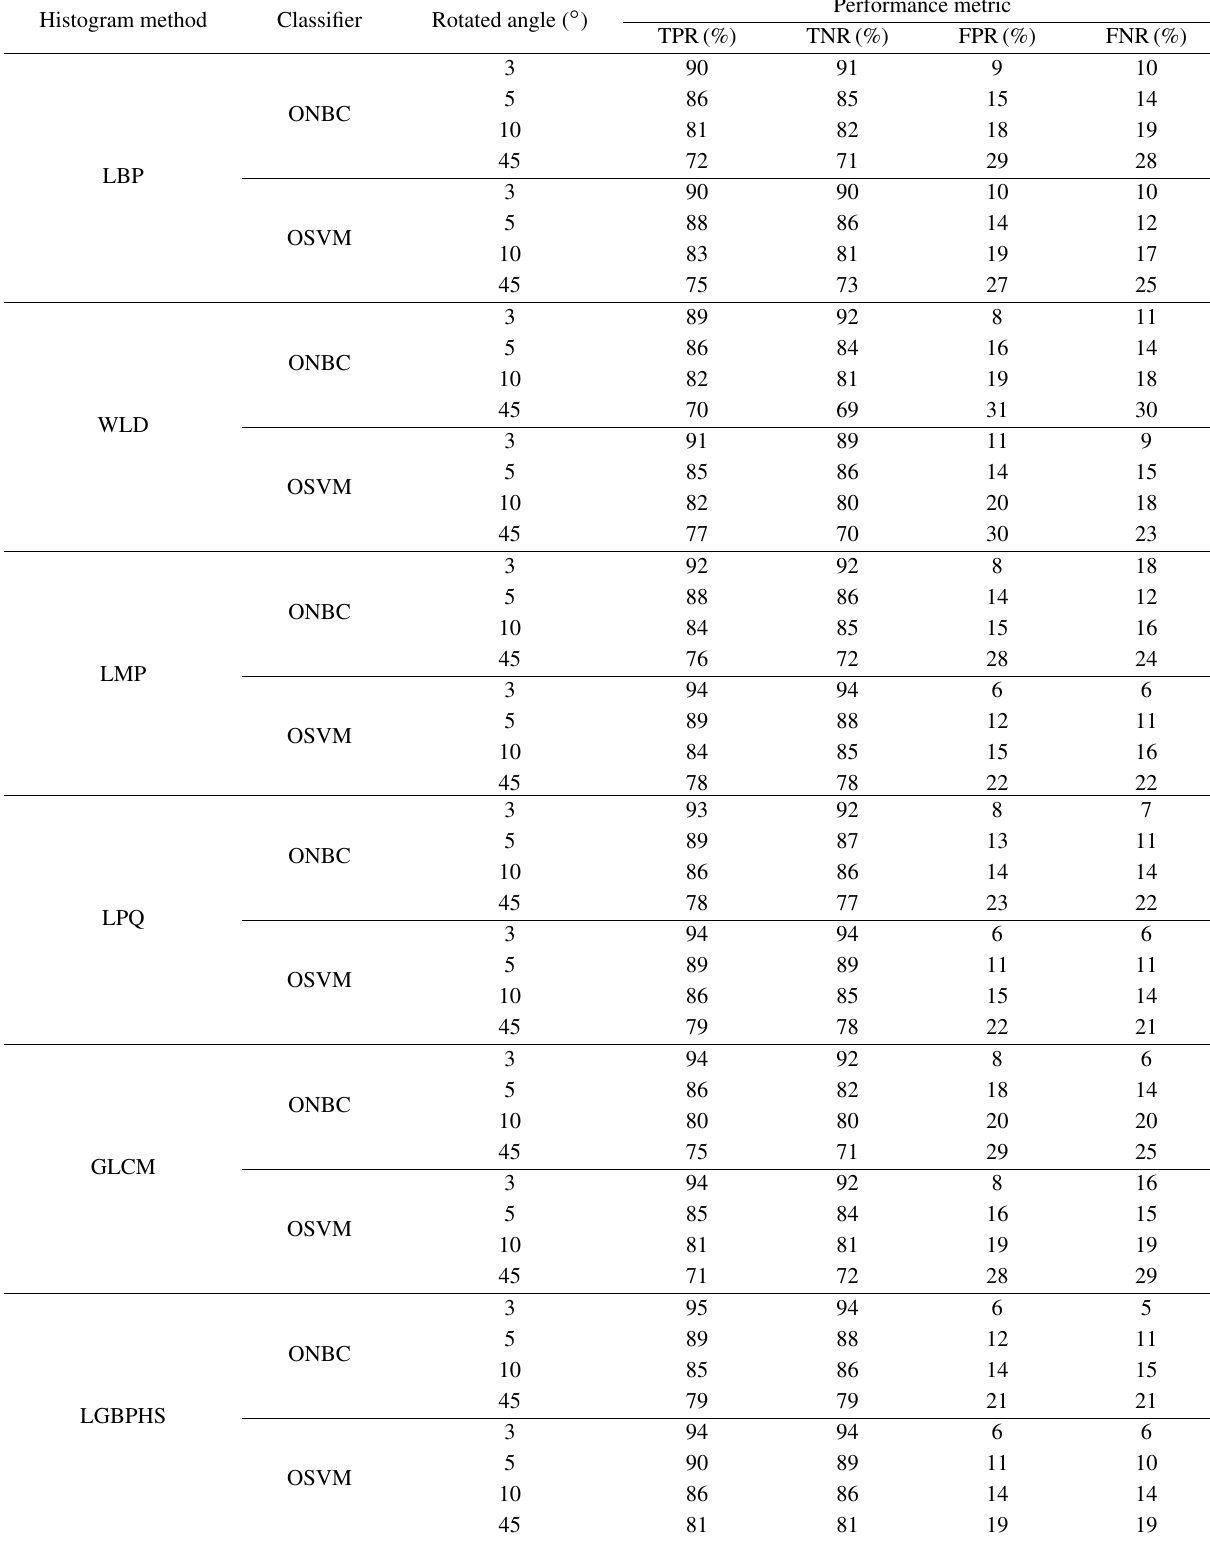
Table 2 Performance of the proposed CMFD algorithms on post-processing attack of angle rotation. Histogram